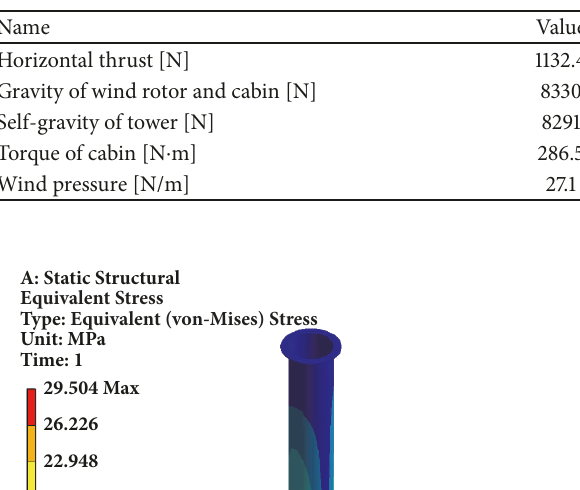
Figure 11: Equivalent stress contour of main axis.